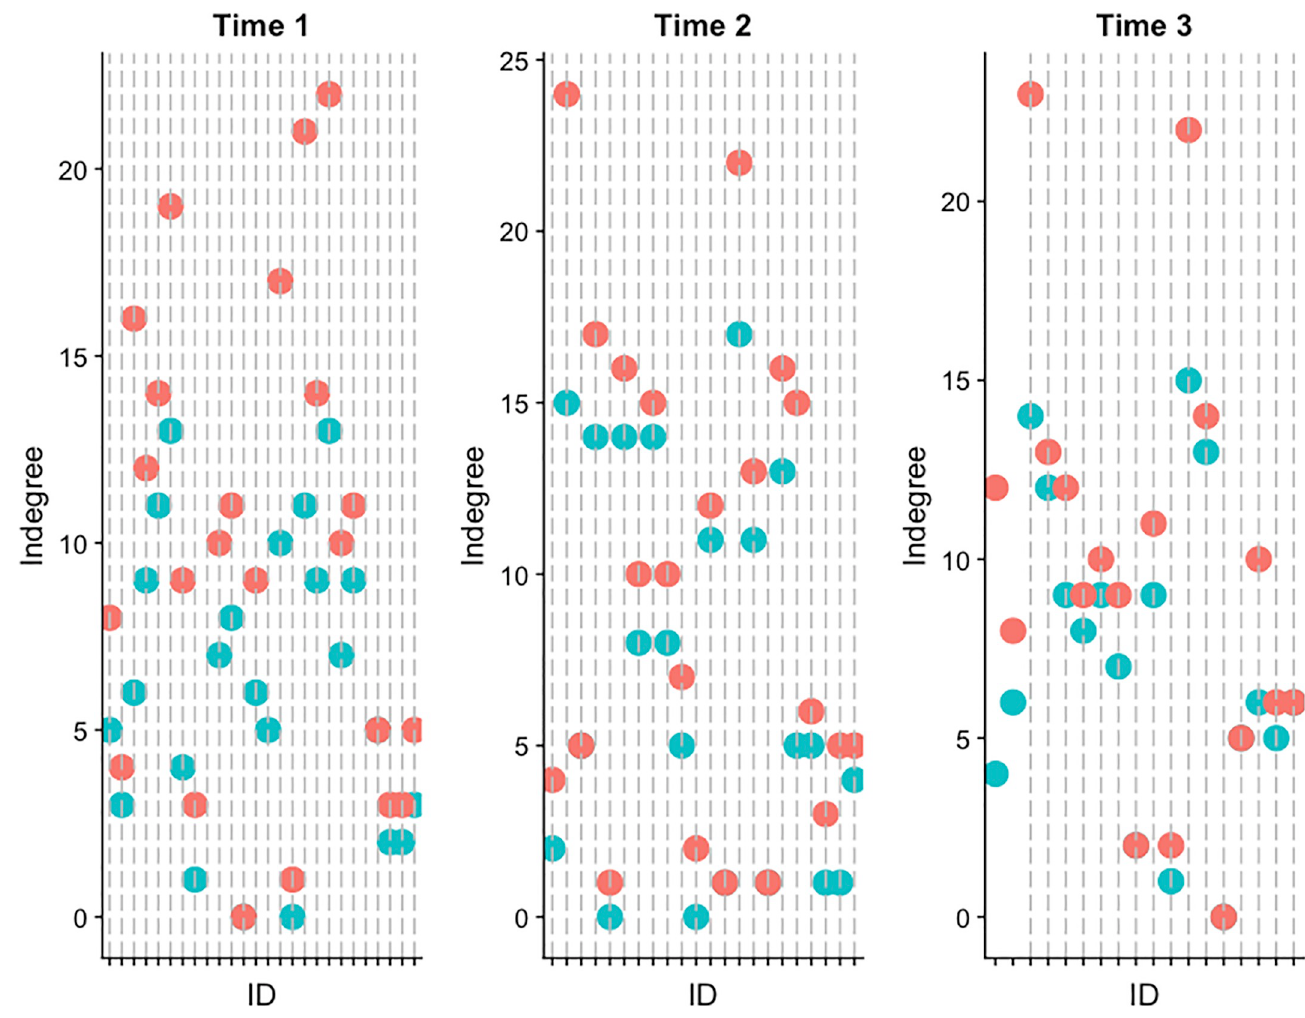
Fig 4. Perceived indegree (red dots) vs. true indegree (green dots).